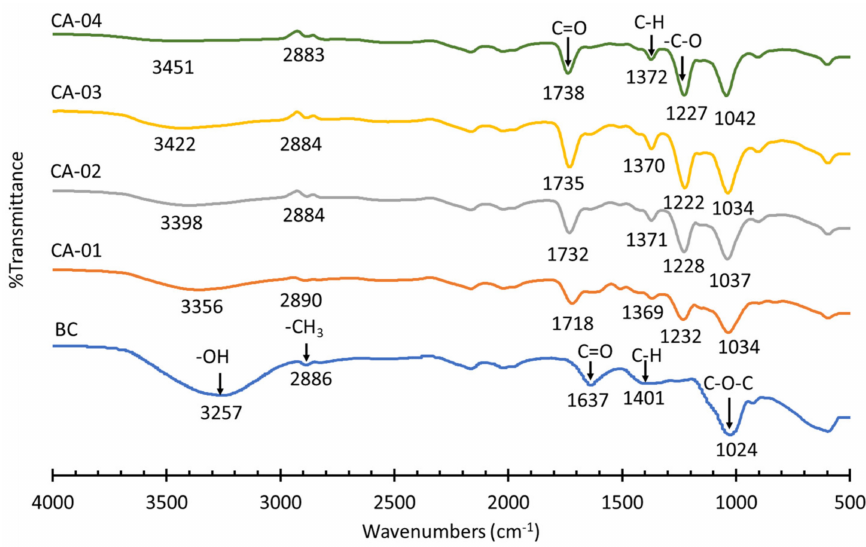
Figure 2. FT–IR spectrum of BC from WWAS and CA derived from the acetylation of